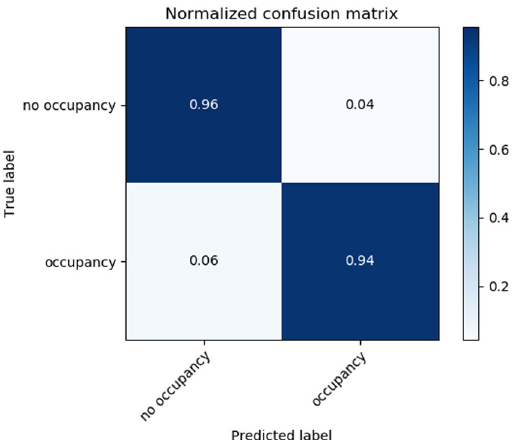
Fig. 6 Confusion matrix for classi fi cation model. Normalized confusion matrix for classifying grid points with and without water occupancy using neural-network model.